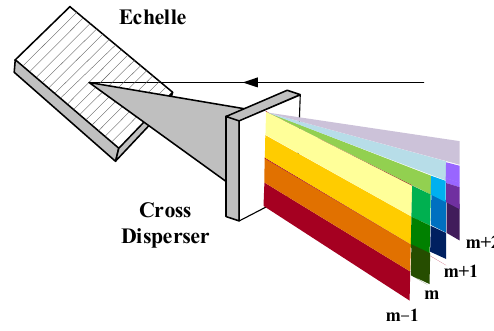
Figure 6. Schematic of cross-dispersion.